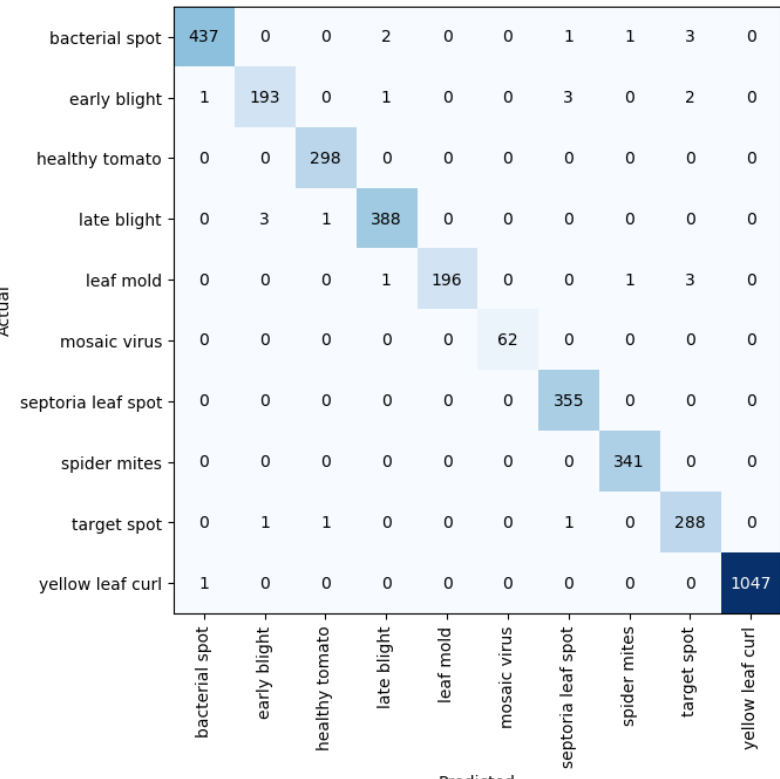
Figure 2. Confusion matrix for network depth = 34.